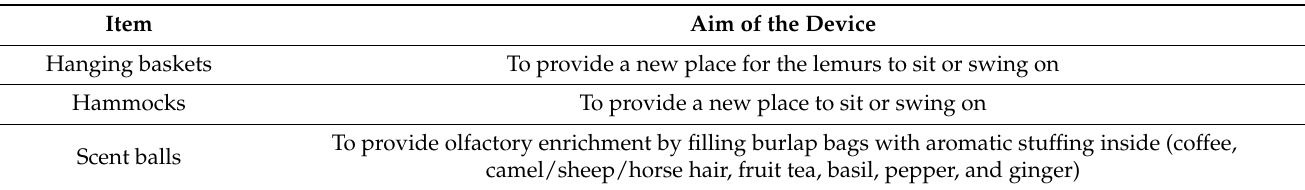
Figure 1. Ring-tailed lemurs interacting with environmental enrichment items: naturalistic looking ( top ) and artificial looking ( bottom ) tube swings. Table 3. Description of the environmental enrichment items used in this study. Several devices were built of each item using naturalistic and artificial-looking